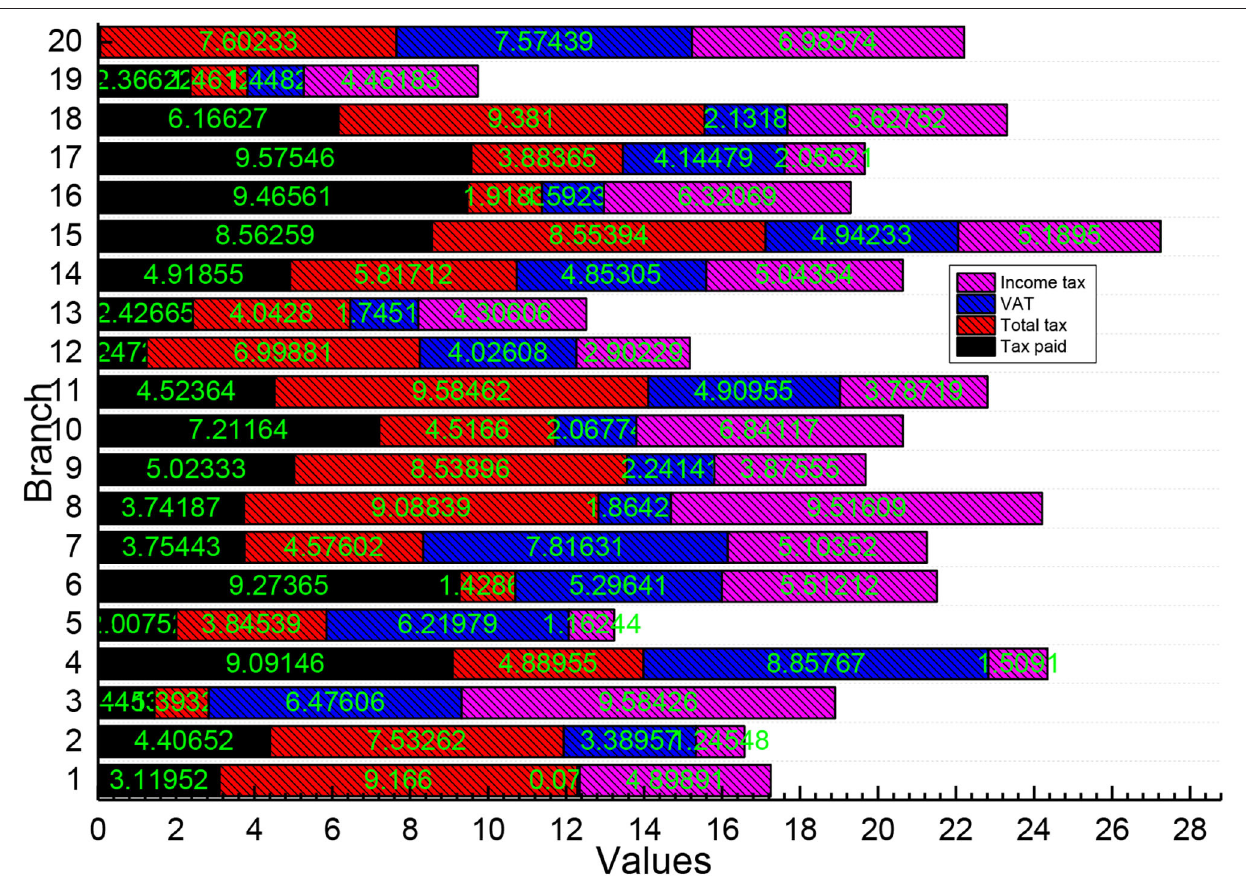
FIGURE 4 | Statistics of tax assessment